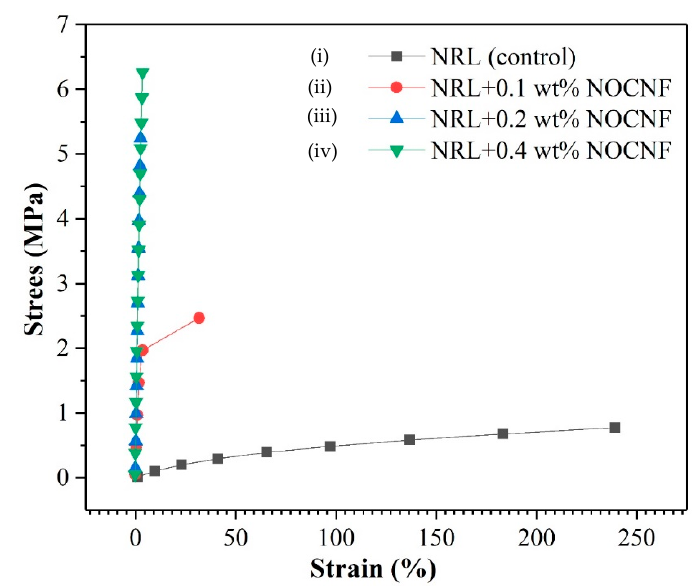
Figure 6. Stress–strain curves on ( i ) NRL film (control), and composite films made of NRL and NOCNF with varying concentration of NOCNF ( ii ) 0.1 wt.%, ( iii ) 0.2 wt.%, ( iv ) 0.4 wt.%.